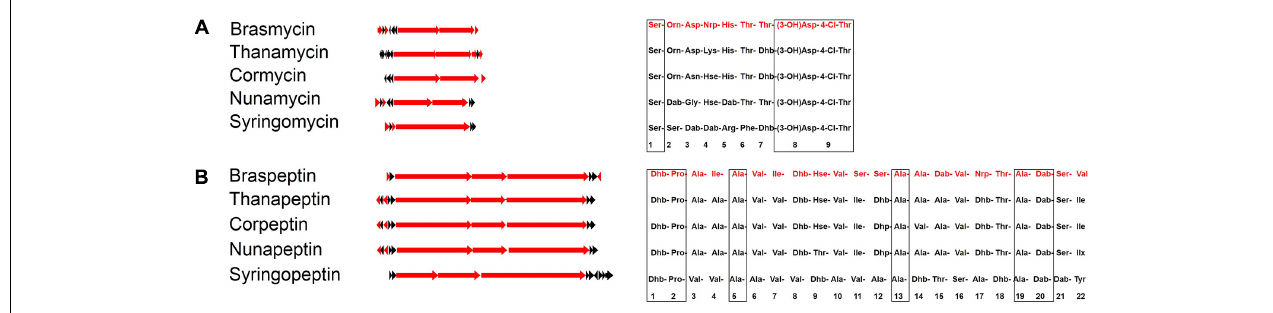
FIGURE 4 | Comparison of brasmycin (A) and braspeptin (B) gene clusters and the predicted amino acid sequences with those of similar CLPs. Red arrows indicate biosynthesis genes, while other genes are indicated by black arrows. Amino acid sequences of brasmycin and braspeptin (in red) were predicated based on A domain phylogenetic analysis. Cormycin and corpeptin from P. corrugata CFBP5454 (ATKI00000000), nunamycin and nunapeptin from P. fluorescens In5 (LIRD01000000), thanamycin and thanapeptin from Pseudomonas sp. SHC52 (CBLV000000000), syringomycin and syringopeptin from P. syringae pv. syringae B301D (CP005969). Consensus amino acids are denoted in boxes. Non-standard amino acids are abbreviated as follows: Dab, 2,4-diaminobutyric acid; Dhb, dehydrobutyrine; Dha, dehydroalanine; Orn, ornithine; Hse, homoserine, Nrp, uncertain amino acids.